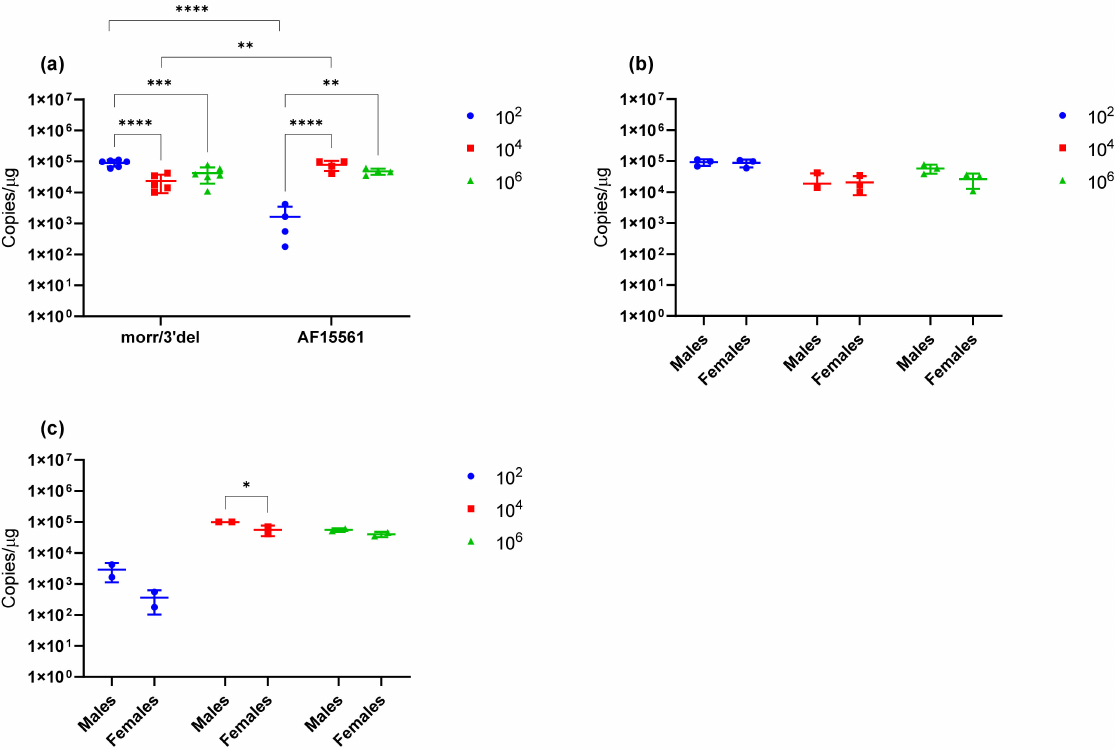
Figure 5. Viral RNA concentrations in the left ankle of animals challenged with CHIKV morr/3 (cid:48) del and AF15561. Values are expressed as copies/ µ g RNA. ( a ) Viral RNA copy number in the left ankle on day 9 post-infection with CHIKV morr/3 (cid:48) del and AF15561 at 1 × 10 2 , 1 × 10 4 and 1 × 10 6 dose levels. ( b ) Viral RNA copy numbers in male versus female animals challenged with CHIKV morr/3 (cid:48) del. ( c ) Viral RNA copy numbers in male versus female animals challenged with CHIKV AF15561. * p < 0.05, ** p < 0.005, *** p < 0.0008, **** p <